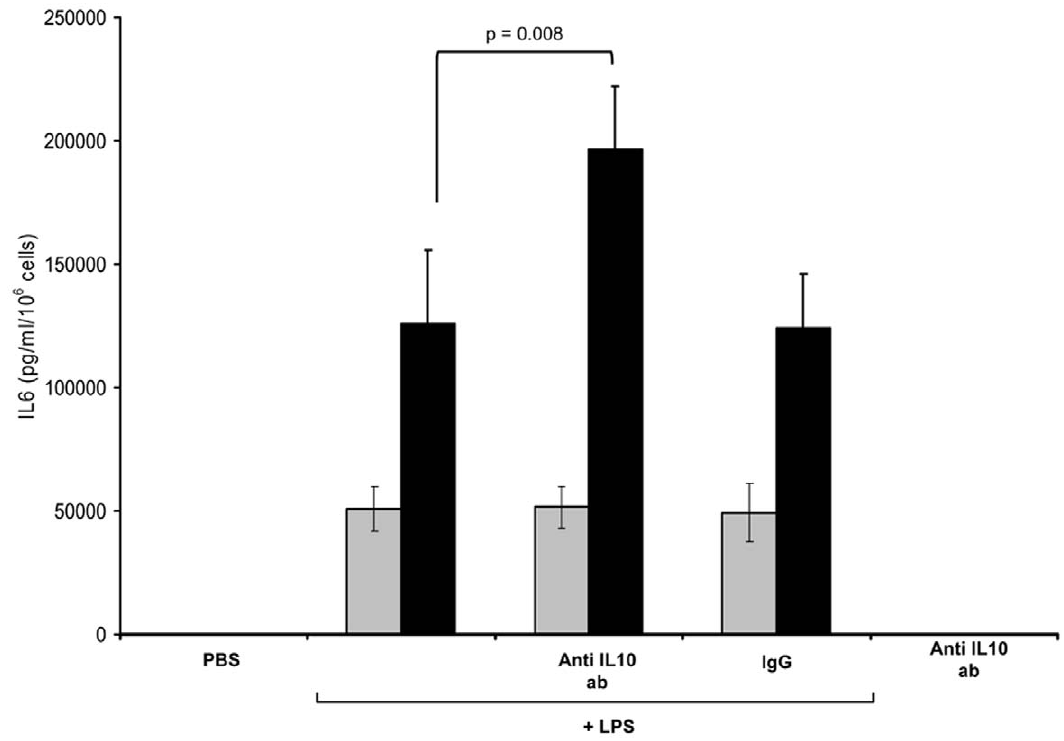
Figure 3. IL-6 release from monocytes of the newly born, measured by ELISA. Monocytes were preincubated with anti-IL-10 antibody for 1 hr followed by endotoxin (LPS) stimulation for 4 h (gray bars) and 18 h (black bars). PBS alone, anti-IL-10 antibody without LPS stimulation and IgG with LPS served as controls. Values are mean 6 SE (n=6).